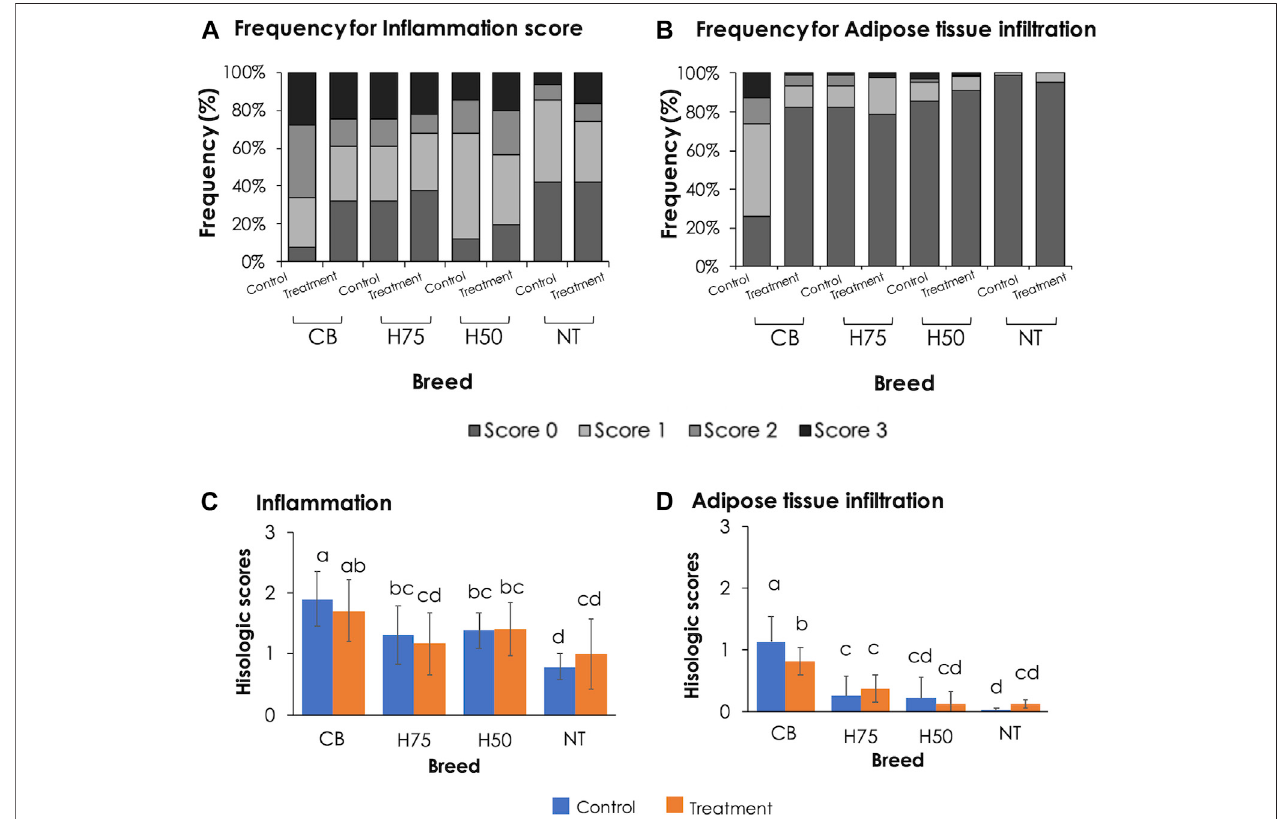
FIGURE3| Bargraphsindicatingfrequencyandaveragehistologicallesionscores. (A,B) Frequency,expressedinpercentage,ofeachhistologicalscoreobserved in pectoralis major muscles of each treatment group. (C,D) Average histological scores. Bars and error bars depict average and standard errors in the scores, respectively. CB: commercial broilers; H75: crossbreeds, 75% broiler background and 25% Thai native background; H50: crossbreeds, 50% broiler background and 50% Thai native background; NT: Thai native chickens. Different letters above bars denote statistical signi fi cance ( p < 0.05).